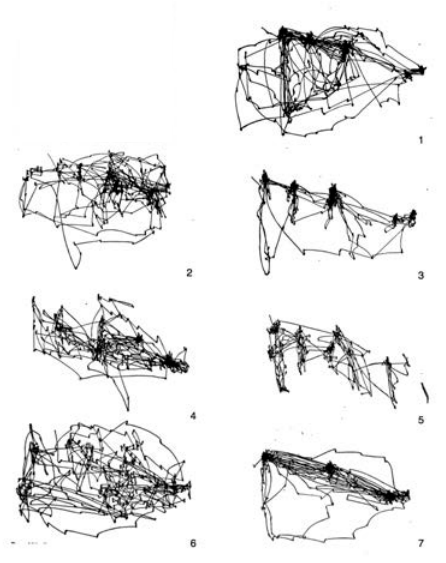
Figure 12. Seven records of eye movements by the same subject. Each record lasted 3 minutes. 1. Free